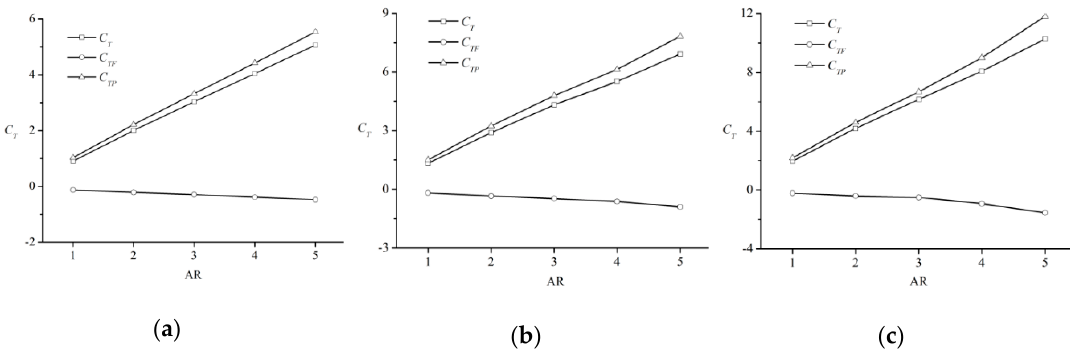
Figure 4. Thrust coefficient of undulatory wing versus magnitude of aspect ratio (AR) under different St numbers. ( a ) St = 0.5; ( b ) St = 1.0; and ( c ) St = 1.5.